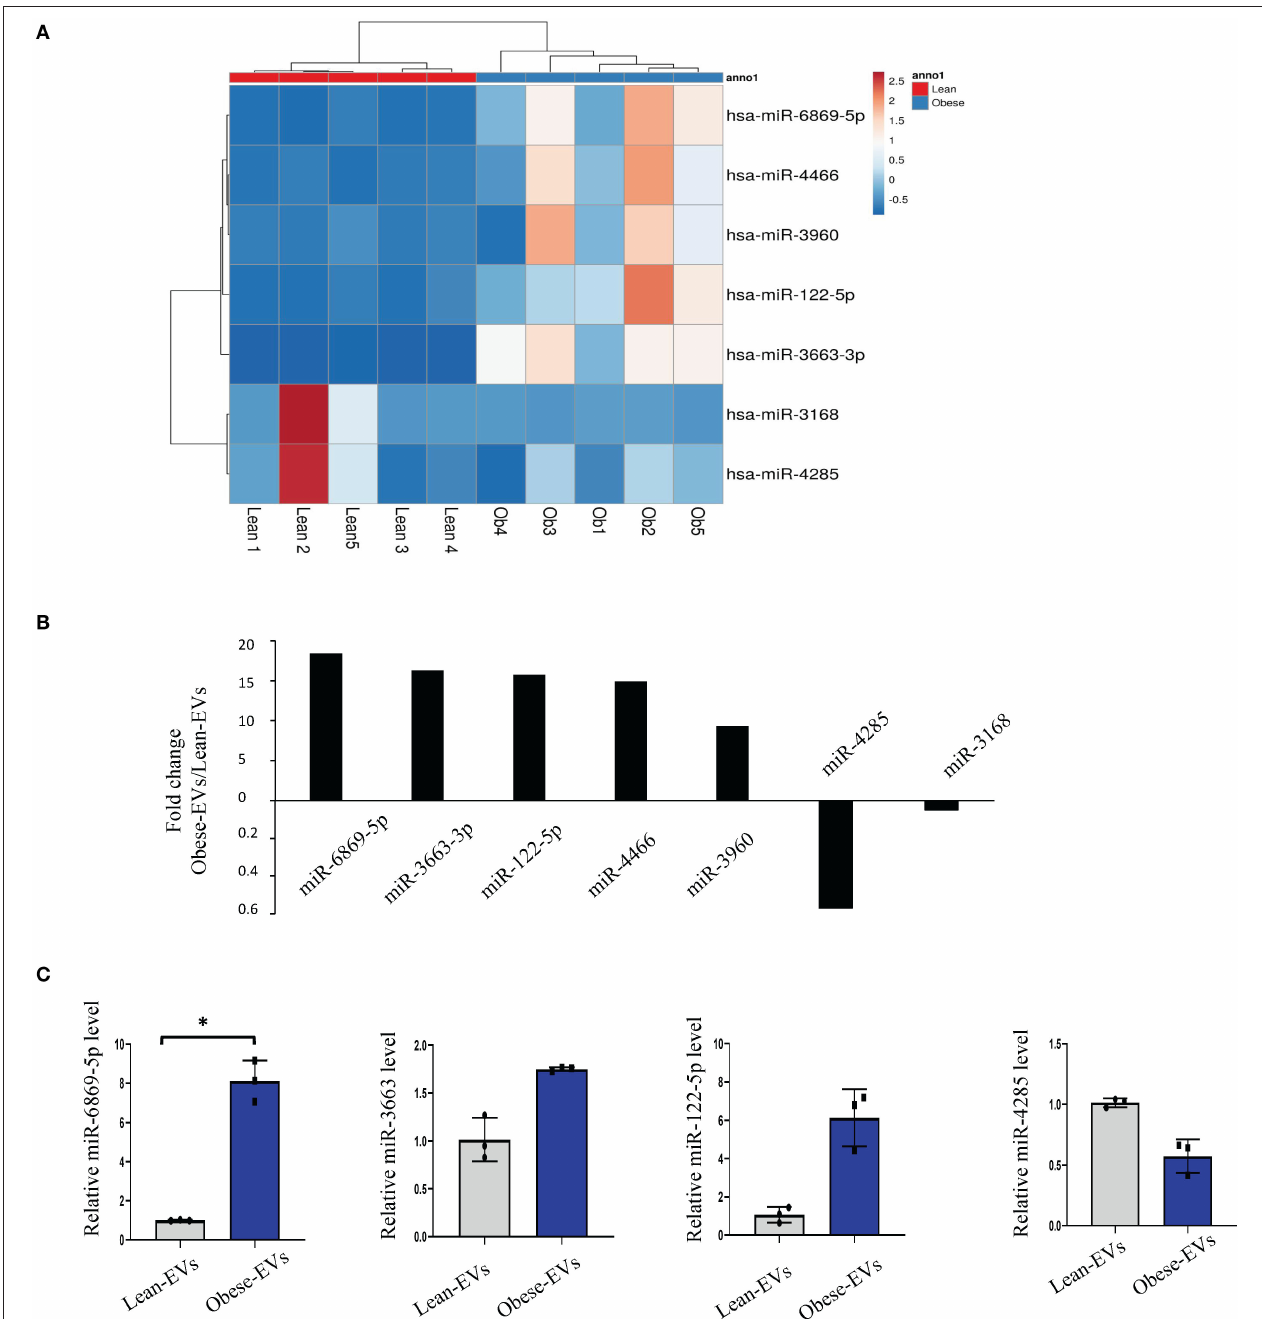
FIGURE 4 | Detection of miRNAs in plasma obese-EVs. (A) Heat map of miRNAs. Five miRNAs were upregulated, and two were downregulated in Obese-EVs compared to Lean-EVs. (B) The expression of candidate miRNAs was consistent with the miRNA-seq findings. miR-6869-5p, miR-3663, and miR-122-5p were upregulated, while miR-4285 was downregulated in Obese-EVs compared to Lean-EVs. (C) Fold-change (Obese-EVs vs. Lean-EVs) of the significantly different miRNAs. ( n = 3; * P < 0.001 vs. Lean-EVs). EVs, extracellular vesicles.